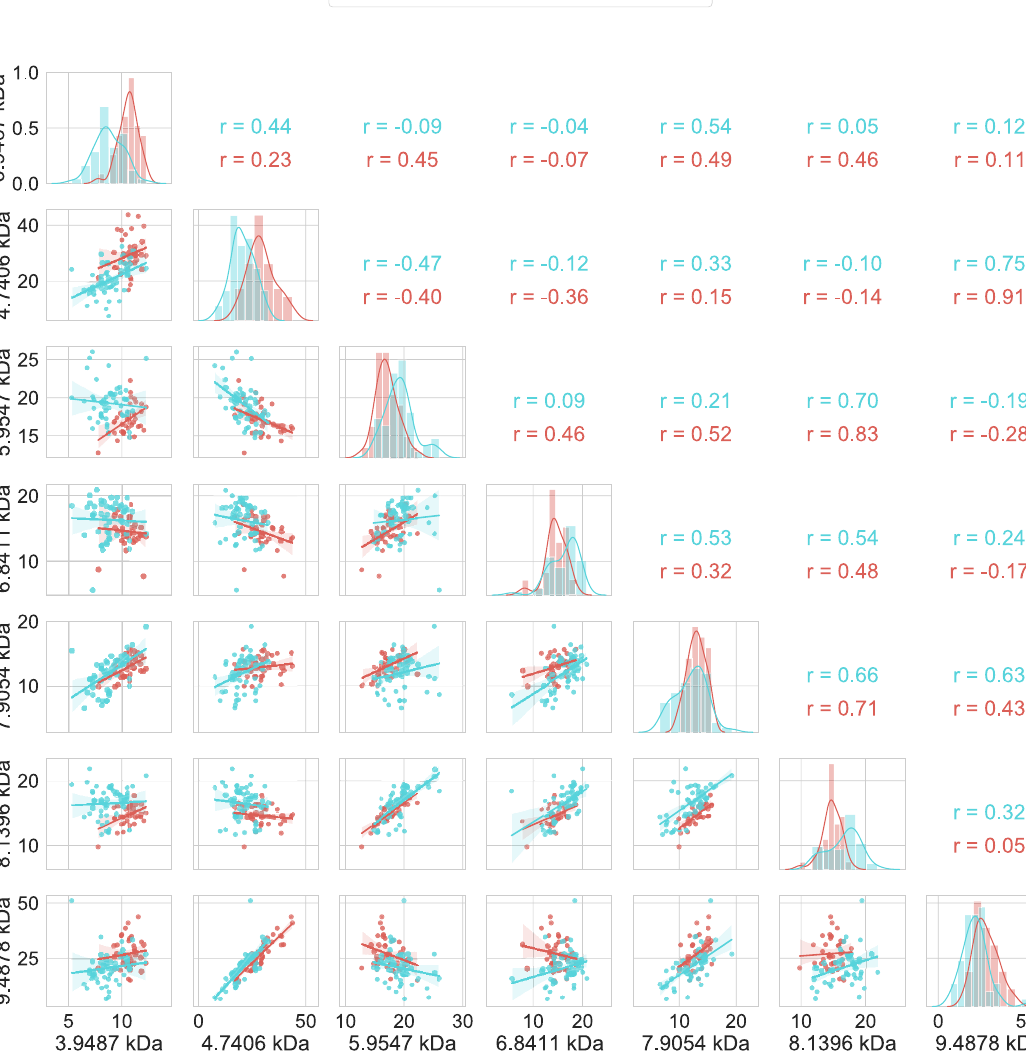
Figure 1. Pair plot pairwise relationship between the most common peaks in the binning method. The responsive and unresponsive intensities are coloured red and blue, respectively. The plots in the lower triangle show the relationship between two peaks for responsive and unresponsive classes; this relationship is in terms of the normalized intensity. The diagonal shows the distribution of the normalized intensity of each peak; the y-axis indicates the frequency while the x-axis indicates the normalized intensity. The upper triangle shows the person correlation for the relationship between two peaks for responsive and unresponsive classes.